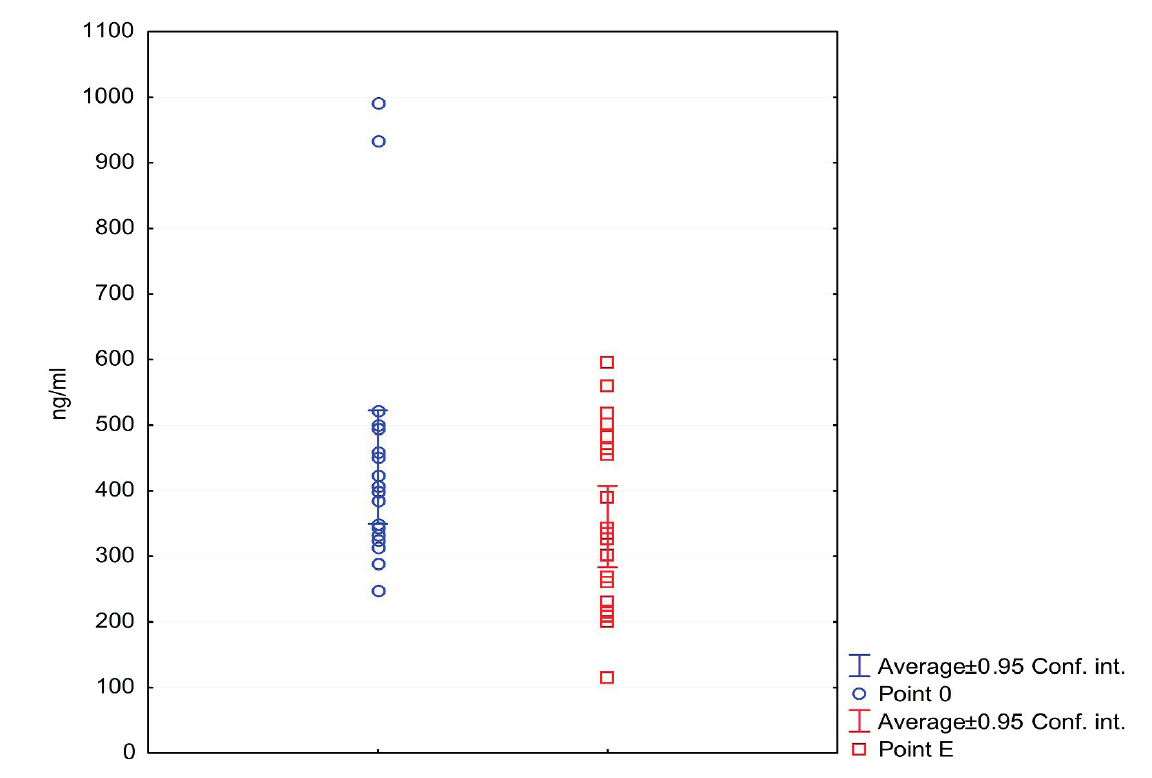
Fig. 4 Scatter plot with 95% confidence interval showing the average concentration of MMP-9 in patients with remission code 1 at two points in time